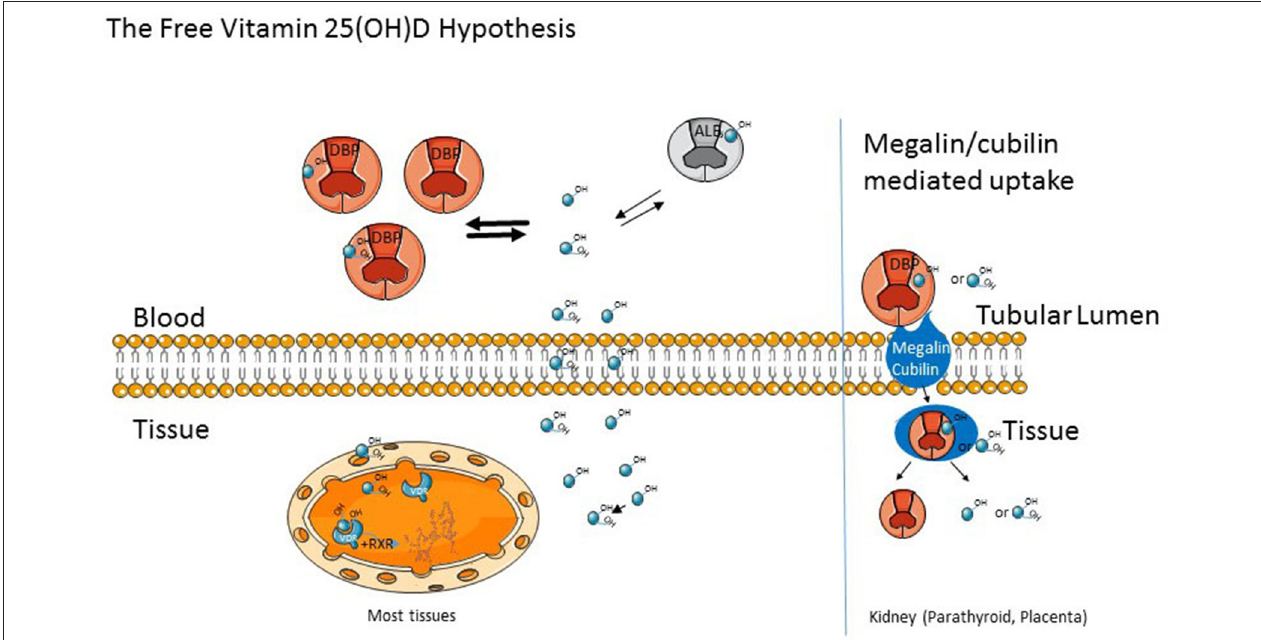
FIGURE 2 | The Free Vitamin D hypothesis. As noted in the text, vitamin D (OH) metabolites are bound to D Binding Protein (DBP) and to a lesser extent albumin in the circulation. These cross the cell membrane as the free (unbound) metabolite in most tissue. However, In the kidney, parathyroid gland, and placenta, the megalin/cubilin complex can transport bound D (OH) metabolites into